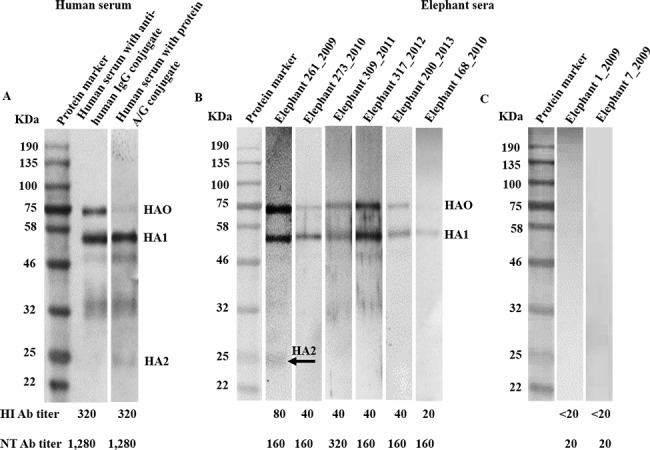
Detection of antibody to H1N1pdm HA using rHA protein as the test antigen in WB assay.(A) Convalescent serum from an H1N1pdm patient recognized the HA0, HA1 and HA2 proteins with MW of 75, 55 and 25 kDa, respectively as using anti-human Ig conjugate or protein A/G conjugate as the secondary detector; (B) Elephant sera with HI antibody titers ≥20 recognized HA0 and/or HA1 proteins, only one serum sample also recognized the HA2 domain; and (C) Elephant sera with HI antibody titer <20 does not react with H1N1pdm HA antigen. Protein A/G conjugate is used as the secondary detector for elephant sera.